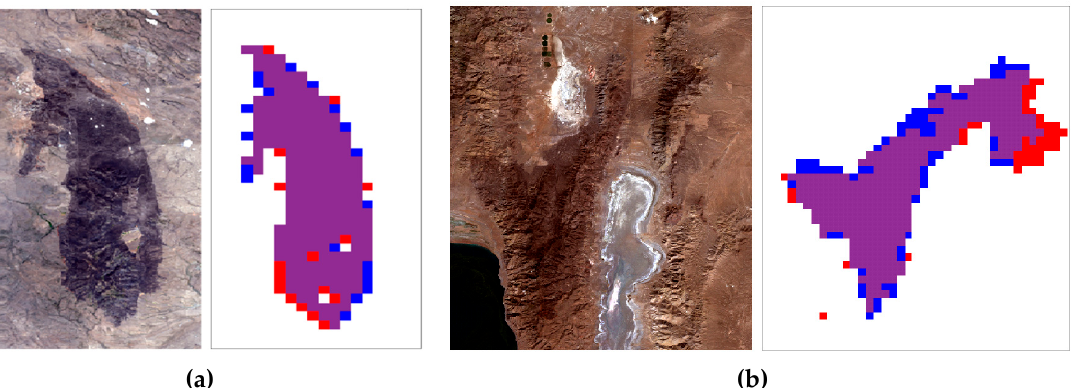
Figure 11. The pixel-wise comparison results of the MODIS-based and OLI-based burned area maps. The images on the left of ( a ) and ( b ) are the true-color composition RGB image of OLI bands 4, 3 and 2, while the images on the right side are the comparison results: the OLI burned area is symbolized by blue, MODIS burned area is red, and the agreement between them is purple. ( a ) OLI image on 17 August 2017 (path/row is 44/30) and the comparison result in Cinder Butte Fire; ( b ) OLI image on 27 September 2017 (path/row is 43/32) and the comparison result for Tohakum 2 Fire.